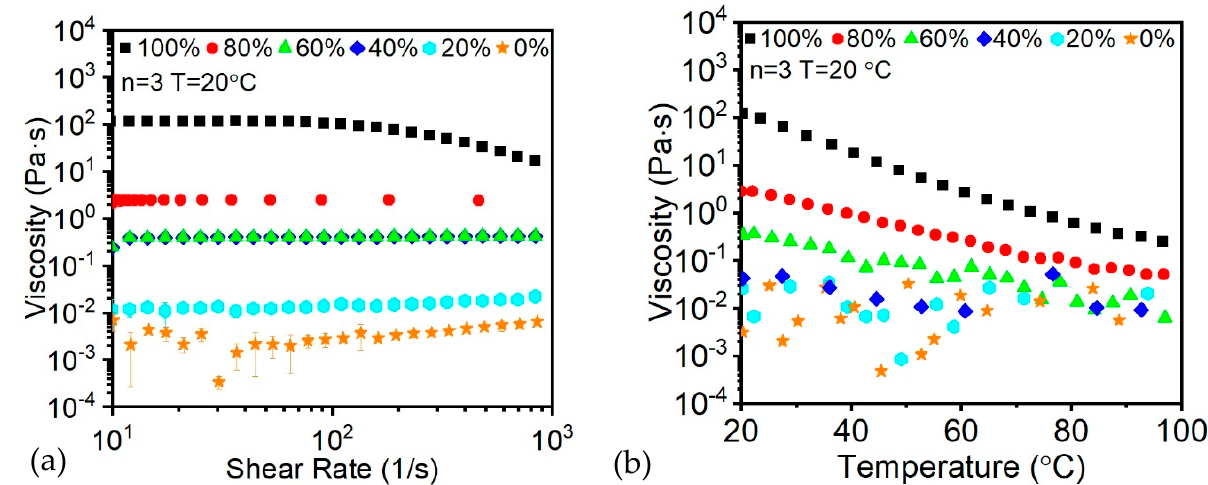
Figure 3. Oligomer ratio − related ( a ) shear thinning; ( b ) temperature dependent viscosity.